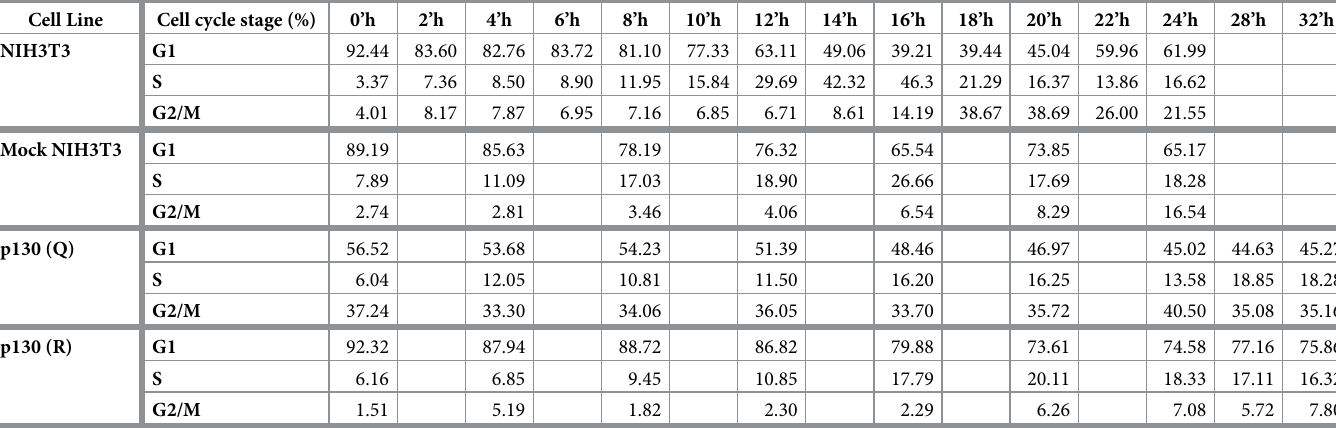
Table 2. Cell cycle analysis of NIH3T3 cell lines. Percentage of cells present in different cell cycle stages is given in h interval after serum restimulation. Cell Line